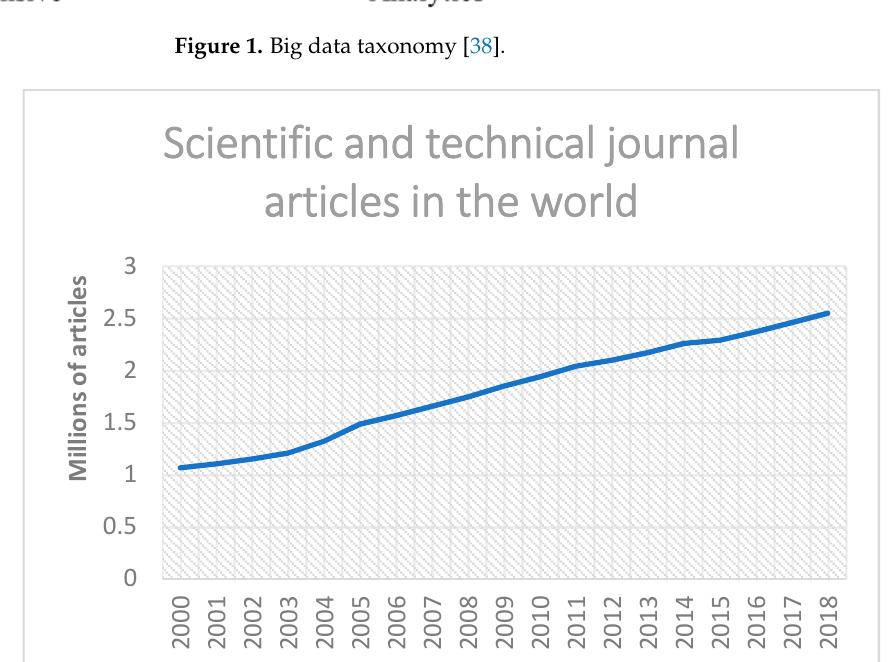
Figure 2. In the world. Source: the world bank, [40].